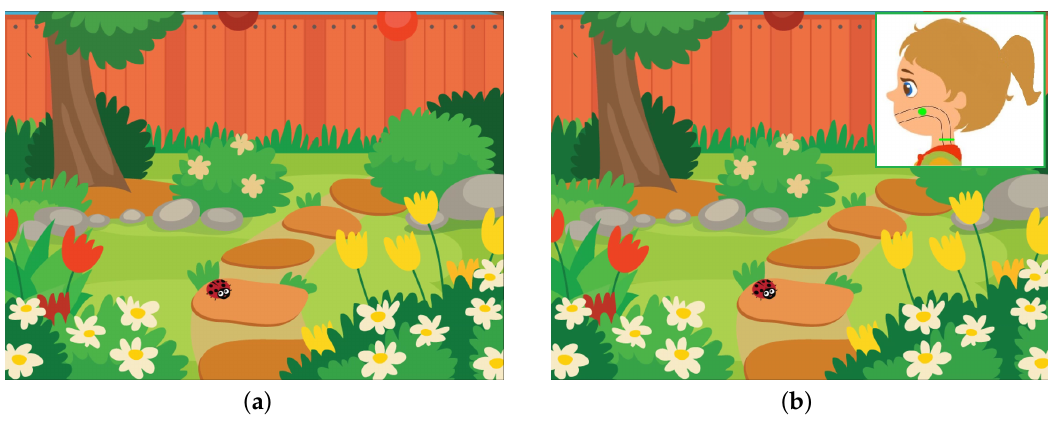
Figure 5. The BioVisualSpeech isolated sibilants game. The scenario for the [Z] sibilant in ( a ) plain mode and in ( b ) vocal tract feedback